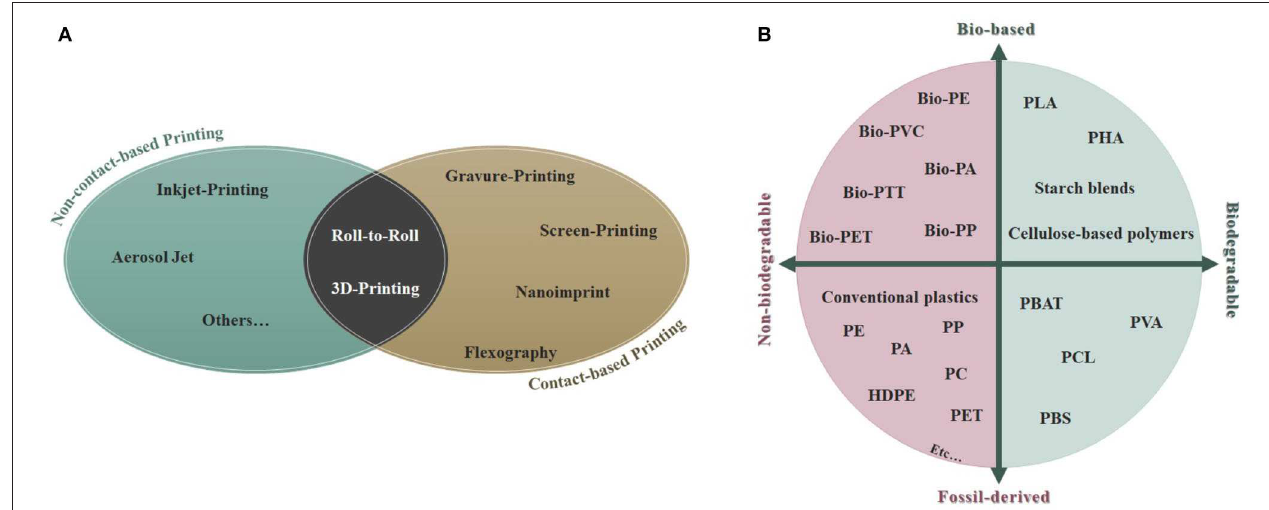
FIGURE 1 | (A) Classification of the main contact- and non-contact based printing technologies; (B) Schematic classification of the different types of plastics and bioplastics. PLA, polylactic acid; PHA, polyhydroxyalkanoate; PVA, polyvinyl alcohol; PBAT, polybutylene adipate terephthalate; PCL, polycaprolactone; PBS, polybutylene succinate; PE, polyethylene; PP, polypropylene; PA, polyamide; PC, polycarbonate; HDPE, high-density polyethylene; PET, polyethylene terephthalate; PTT, polytrimethylene terephthalate; PVC, polyvinyl